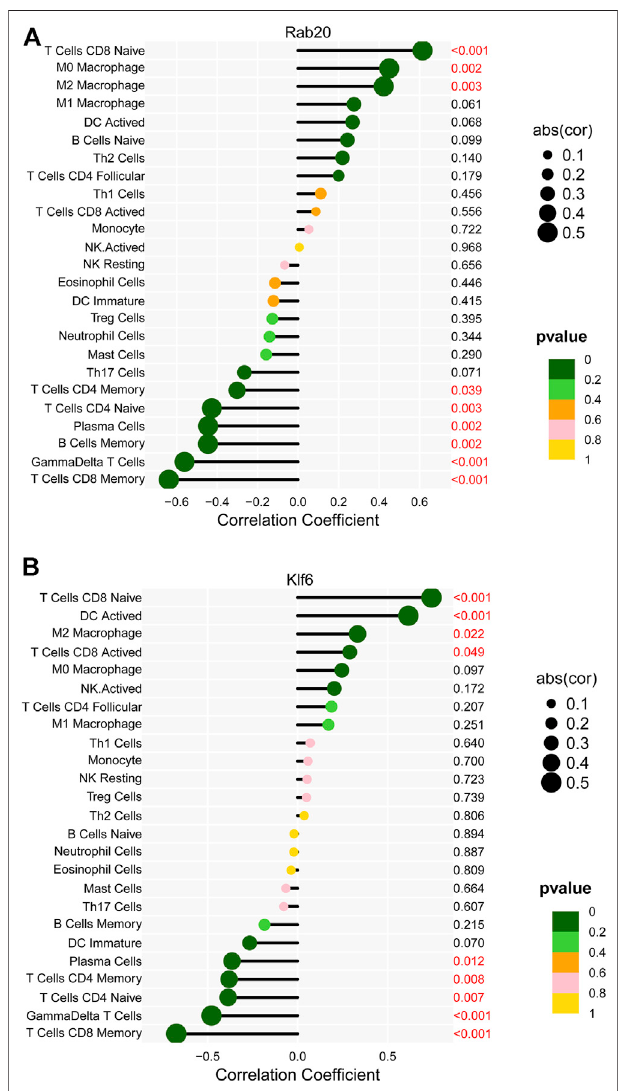
FIGURE 8 | The Correlation between key markers and in fi ltrating immunecells. (A) CorrelationbetweenRab20andin fi ltratingimmunecells. (B) Correlation between Klf6 and in fi ltrating immune